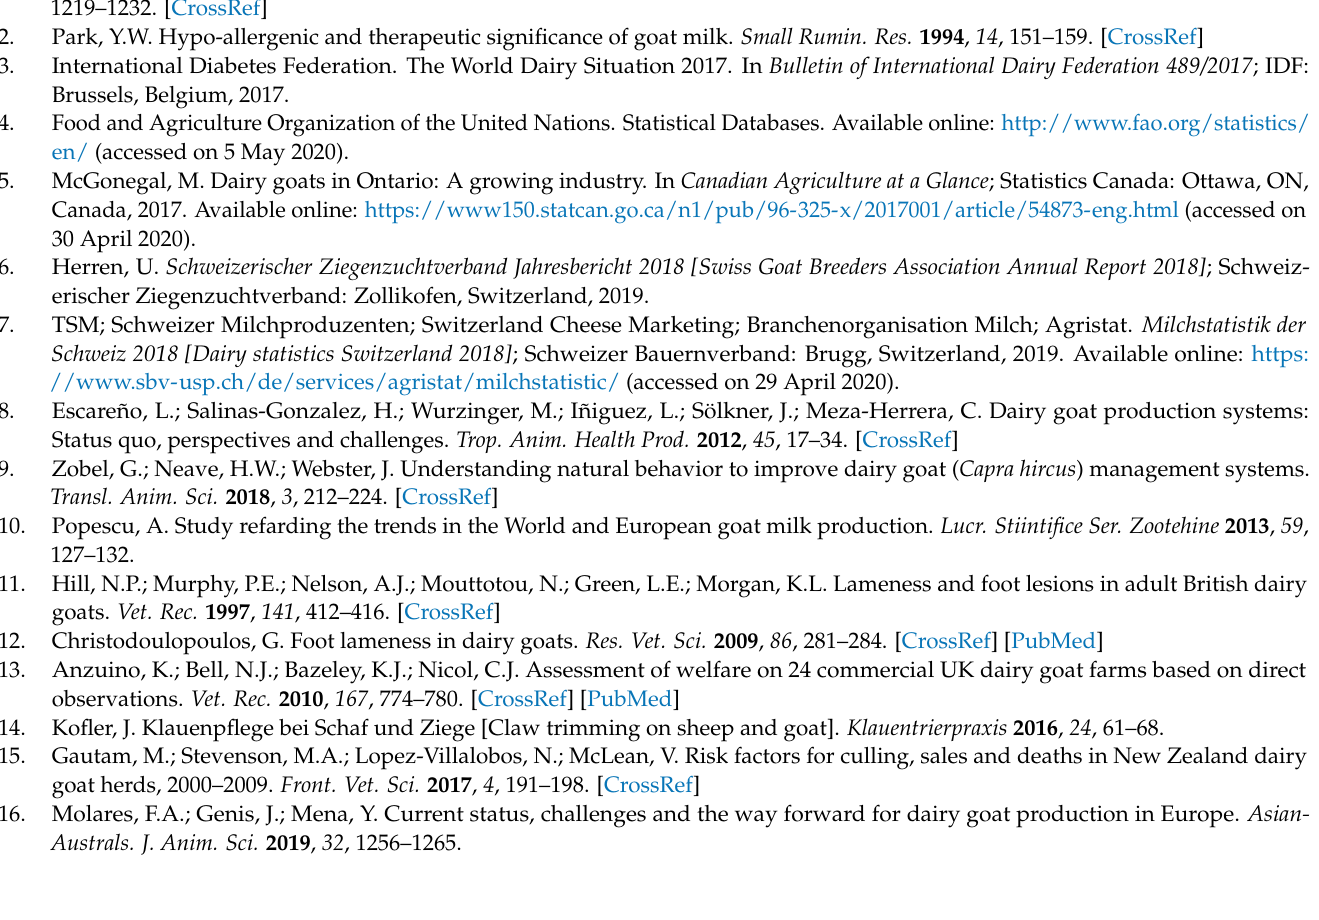
Table S4 Animals affected with horn separation, sole hemorrhage and with bleeding due to trimming in autumn and spring, with number of claws affected per animal, Table S5: Animals affected with sole hemorrhage in autumn and spring, with number of claws affected per animal., Table S6: Animals affected with bleeding due to trimming in autumn and spring, with number of claws affected per